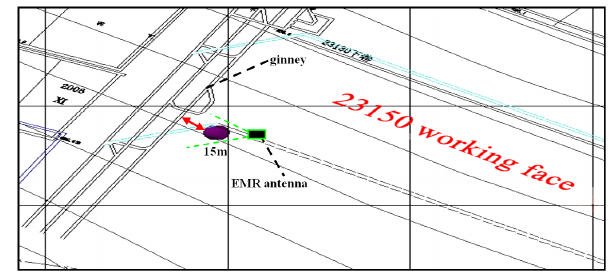
Figure 4. Schematic of EMR monitoring in the mining